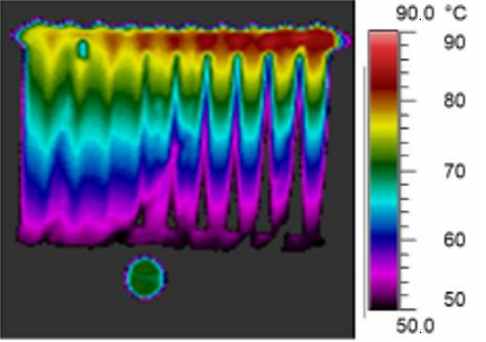
Figure 16. Radiator T1 surface temperature distribution according thermography measurements , mea- surements 4 , flow q mx = 0.0051 kg/s— 59% nominal value .